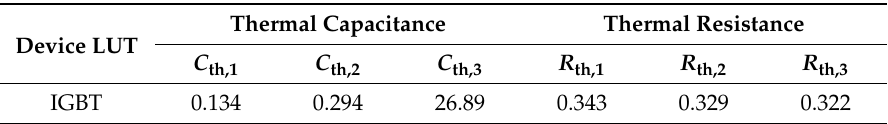
Table 3. Thermal impedance characteristics of